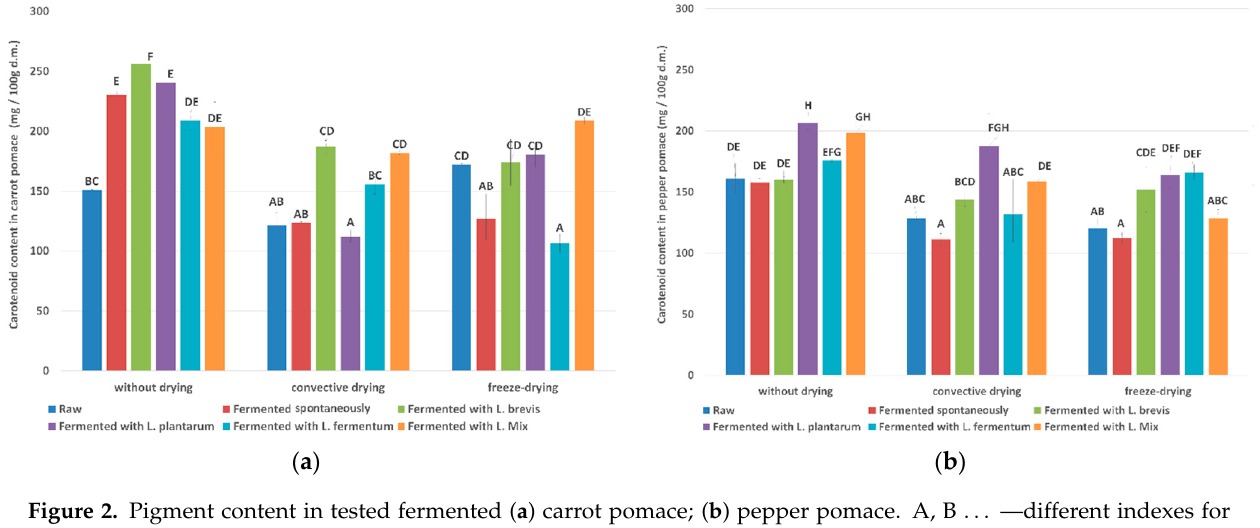
Figure 2. Pigment content in tested fermented ( a ) carrot pomace; ( b ) pepper pomace. A, B…—different indexes for individual series mean statistically significant differences for given values at the level of p < 0.05.